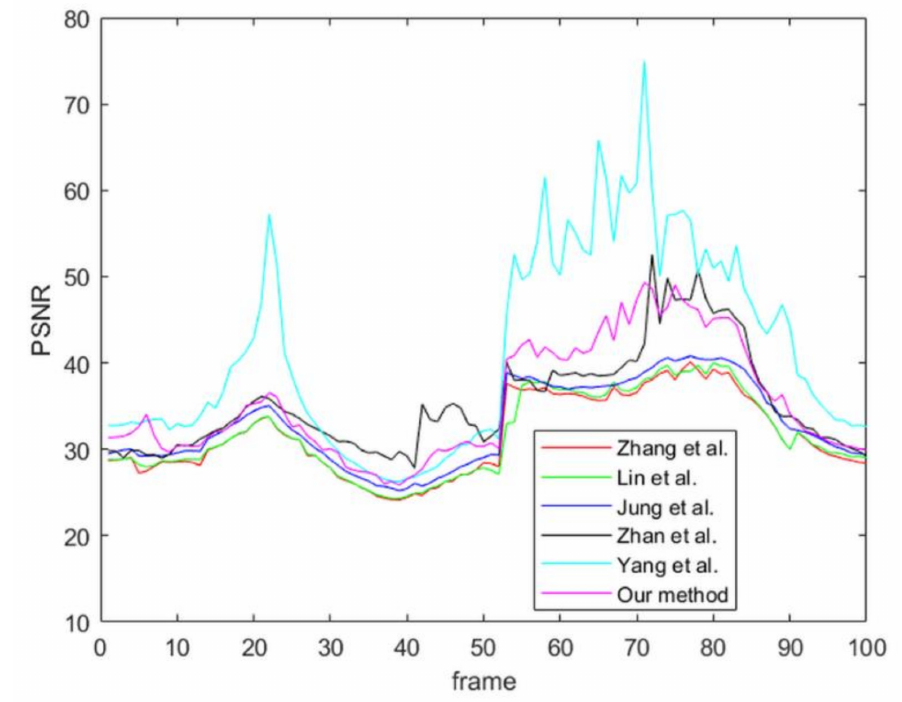
Figure 8. PSNR values for tunnel video clip in comparison of our proposed method, and methods of Zhang et al., Lin et al., Jung et al., Zhan et al., and Yang et